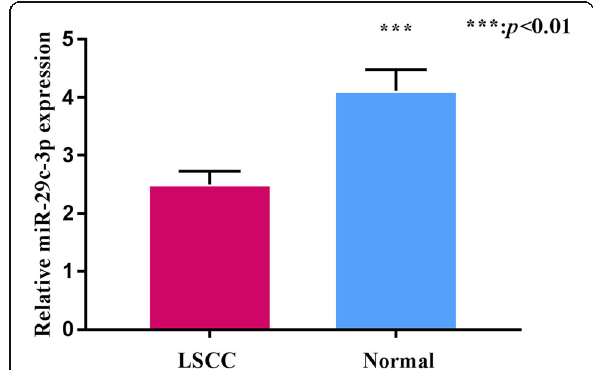
Fig. 1 Relationship between miR-29c-3p expression and clinicopathologic parameters in LSCC